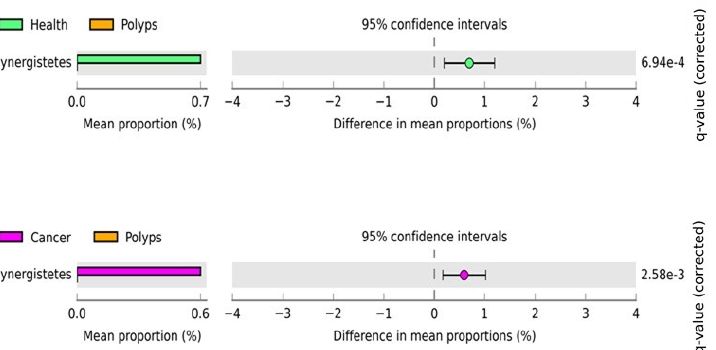
Figure 3. The post hoc plot of enriched bacterial phyla among three health conditions (healthy, polyps, and cancer). The left side of these figures shows the abundance ratio of differentially enriched bacterial phyla. The right side represents the significant difference at p < 0.05, whereas the middle one indicates the mean proportion of differentially enriched bacterial phyla in the 95% confidence.